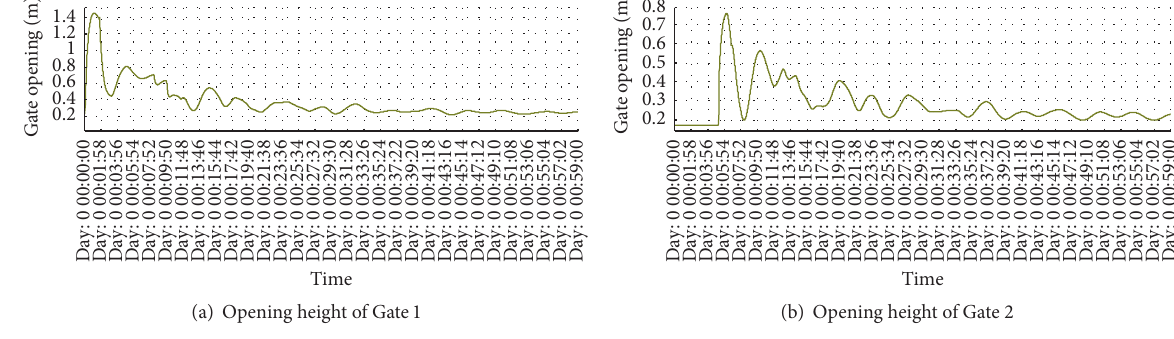
Figure 5: Evolutions of water levels at four points.